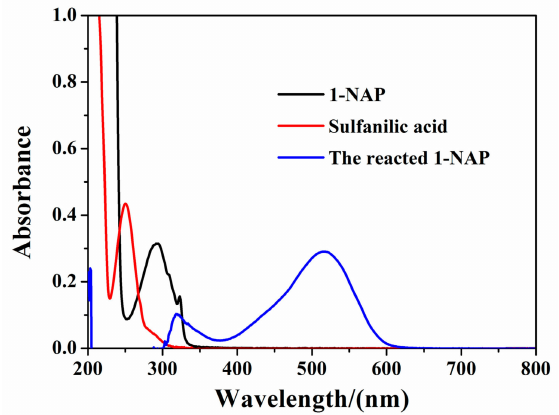
Figure 3. UV-VIS absorption scan.